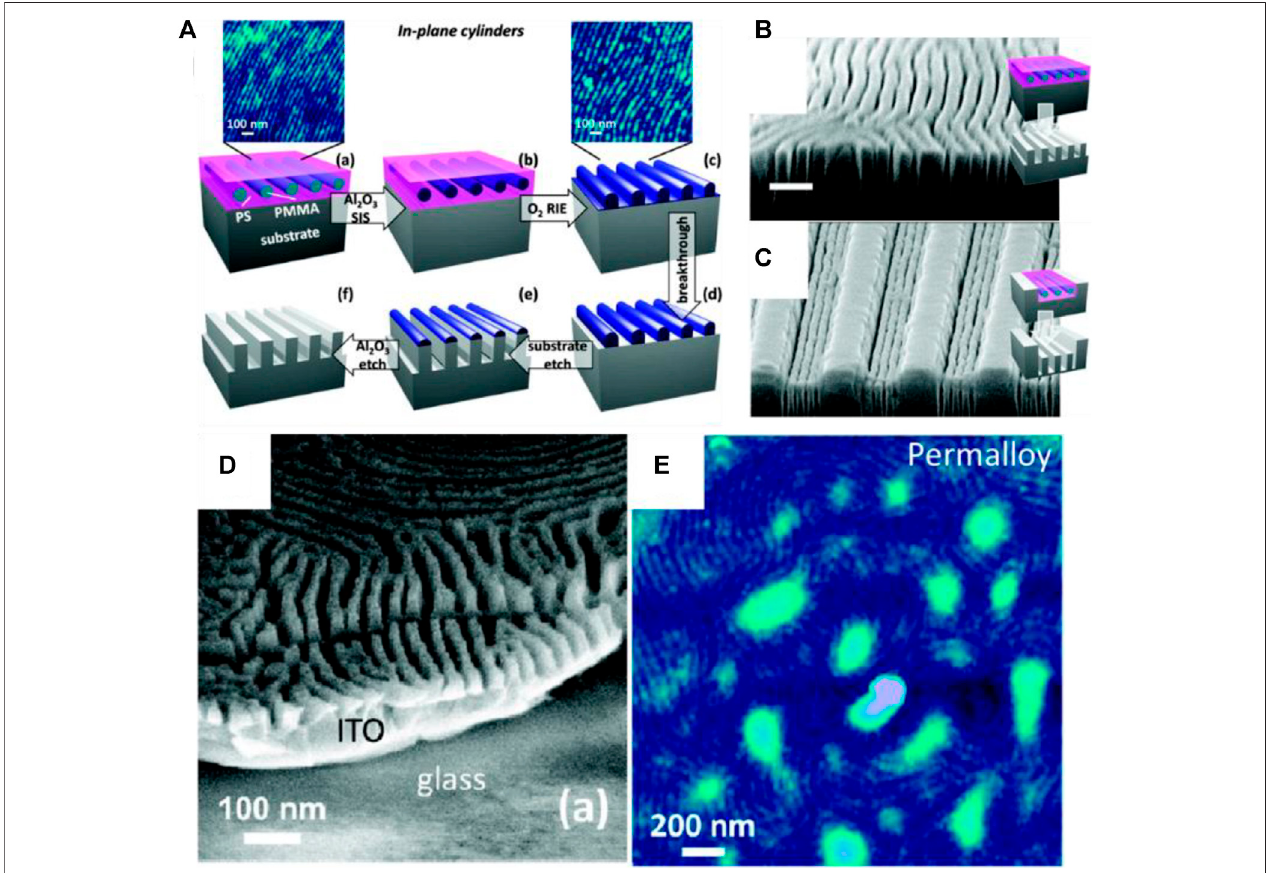
FIGURE 11 | (A) Schematic for patterning underlying substrates using in fi ltrated hybrid BCPs with in plane cylinder morphology; Pattern transfer into underlying siliconusingHBr-basedplasma,withAlO x in fi ltratedPS- b -PMMA fi lmasetchmask (B) fromin-planePMMAcylinders. (C) BCP fi lmalignedusinggraphoepitaxy;pattern transfer using the BCP-AlO x hybrid fi lm into (D) indium tin oxide using plasma etching; and into (E) permalloy (Ni 0.8 Fe 0.2 ) using CO-based plasma etching. Reproduced with permission from ref (TsengTseng et al.,